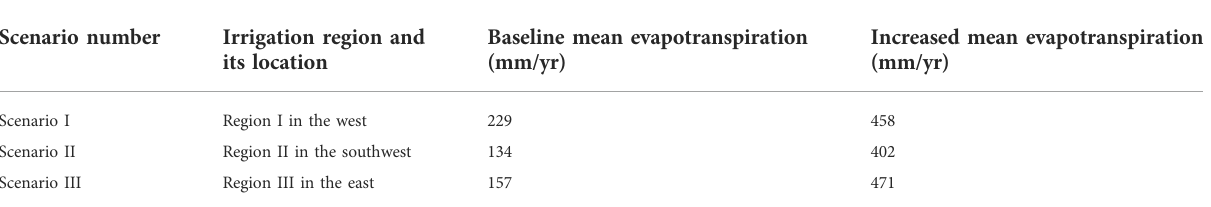
TABLE 1 Scenario setting of different irrigation